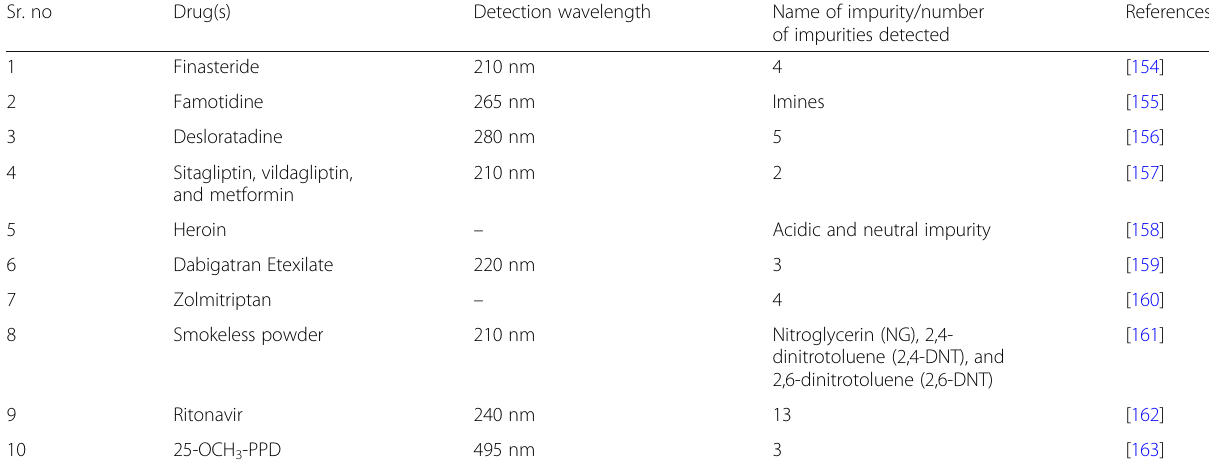
Table 5 Impurity profile of drug using UHPLC-MS/MS Sr.